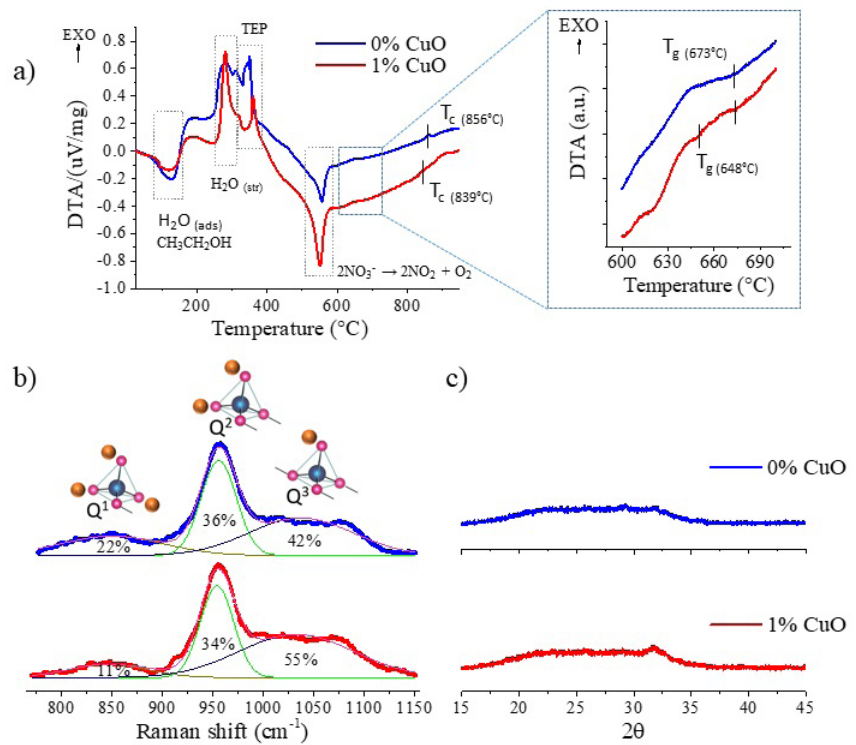
Figure 2. a) DTA curves obtained from CuO-containing bioactive glasses showing the main thermal events, the chemical changes associated with each event, crystallization temperatures, and magnified region of the glass transition temperatures. b) Raman spectra